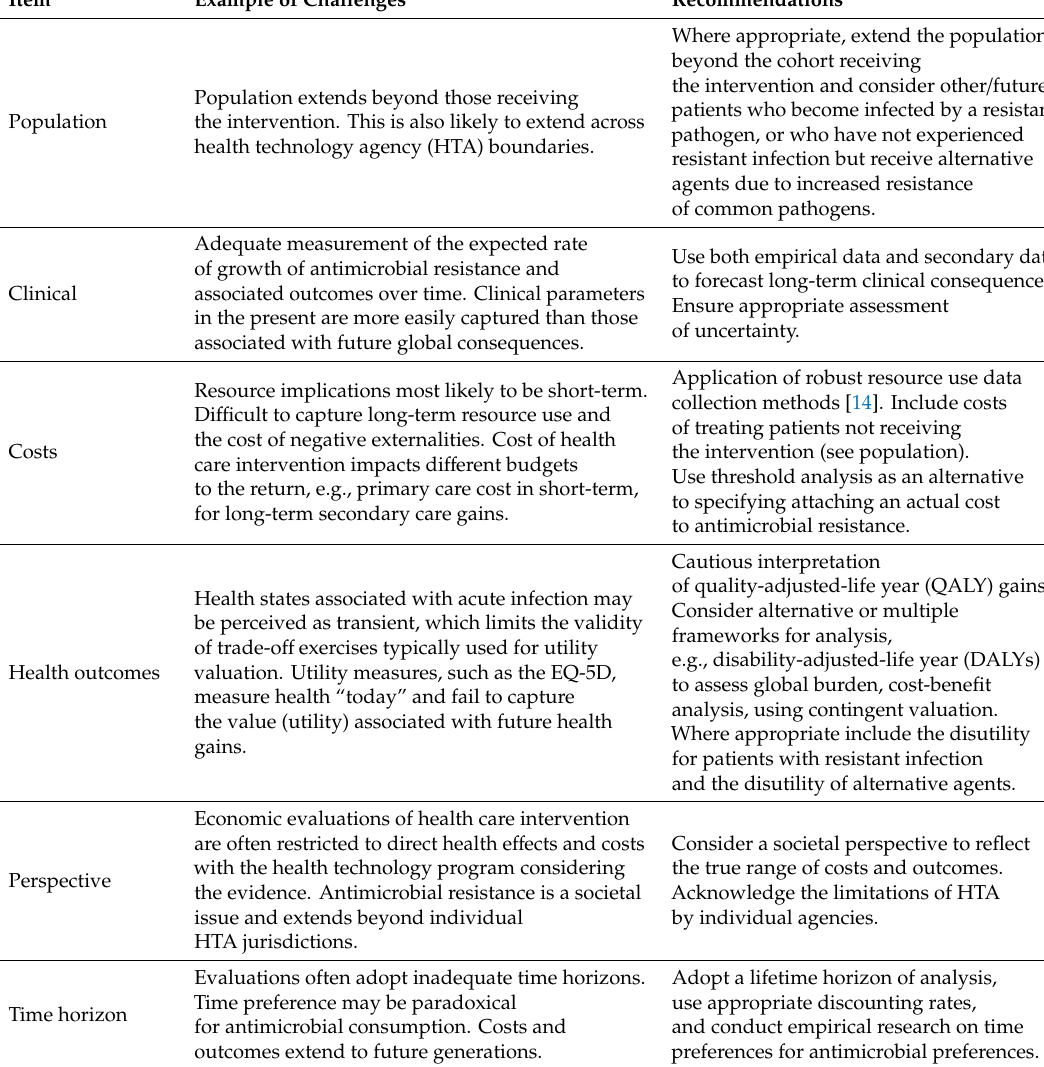
Table 1. Examples of challenges for the economic evaluation of health care strategies to contain antimicrobial